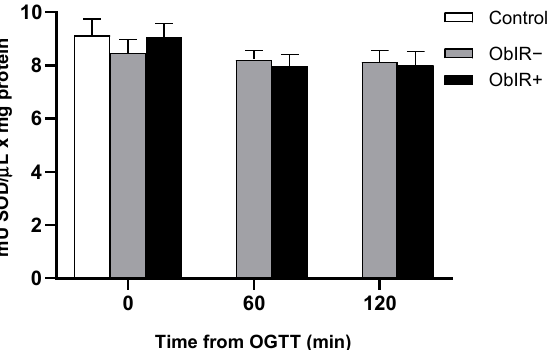
Figure 7. Superoxide dismutase activity were measured in RBC of healthy and obese children at baseline and along OGTT. White bars represent the control group, grey bars represent ObIR − group, and black bars represent ObIR+ group. Values are means ± SEM. p < 0.05 was considered for